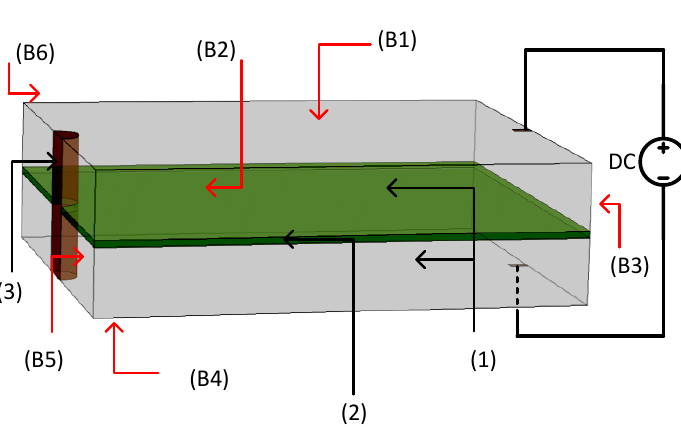
Figure 3. Geometry description: Lamination ( 1 ), insulation ( 2 ), fault region ( 3 ), thermal boundary condition (B1–B6), and DC supply.